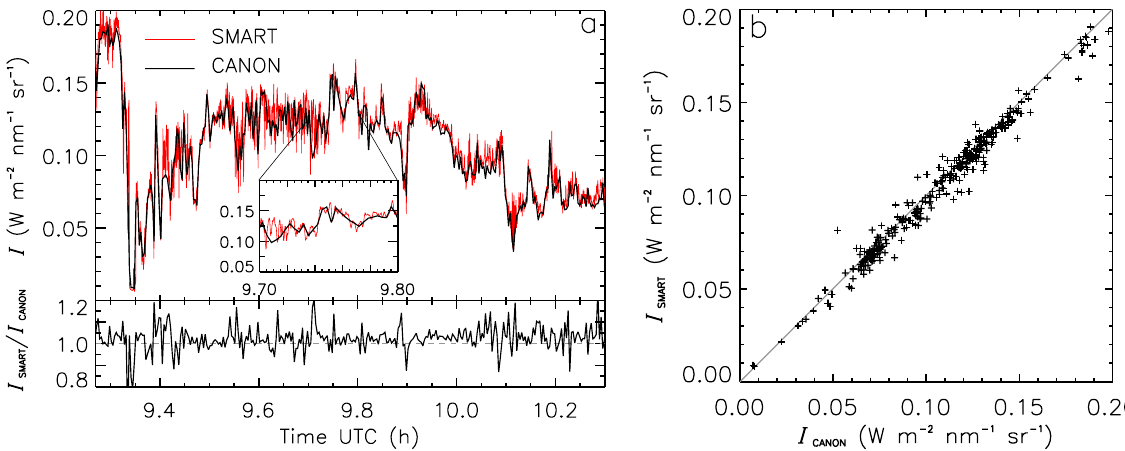
Fig. 5. Time series (17 May 2010) comparison (a) of a spectral radiance measured by the SMART-Albedometer (red) and by the CANON camera (black). Data are shown for the red camera channel ( λ = 591nm). The correlation between both measurements is illustrated in second panel (b)